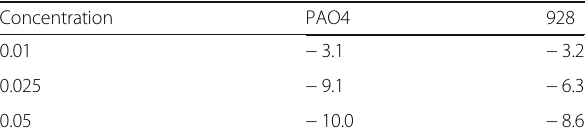
Table 3 The slope of the linear fitting curve of the linear tail end of the normalized adsorption of the SA-GO (prepared by sulfur-doped GO and octadecylamine, the oxidation time of the GO is 24 h) in PAO4 and 928 oils (× 10 − 5 ) Concentration PAO4